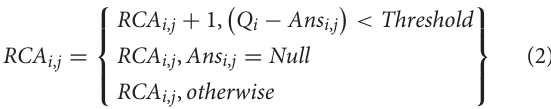
TABLE 1 | Summarizes of notations and